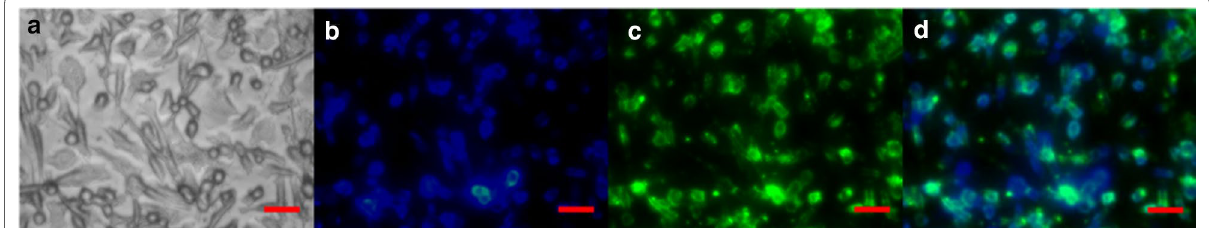
Fig. 3 Evaluation of the cell internalization of FITC‑AuNC@SiO 2 . PC‑3 cells were treated and incubated with 2 μg of FITC‑AuNC@SiO 2 3 h at 37 °C. The cells were then washed, incubated with DAPI for nuclei‑staining, and analyzed using fluorescence microscopy. Bright field image ( a ), blue fluorescence image of PC‑3 cells for nuclei‑staining DAPI ( b ), green fluorescence image of PC‑3 cells for FITC ( c ). d is a merged image of b and c . The size of scale bars is 100